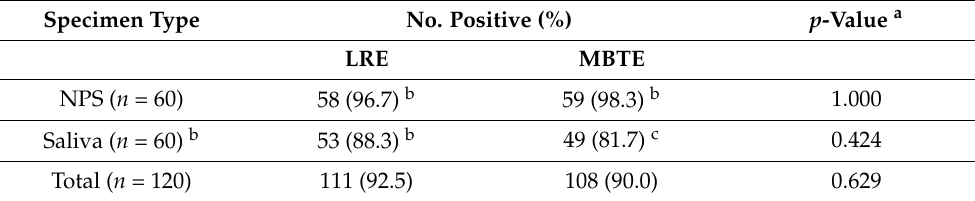
Table 1. Comparison between the detection rate in 120 positive pooled respiratory specimens extracted by liquid-based RNA extraction and magnetic bead-based total nucleic acid extraction